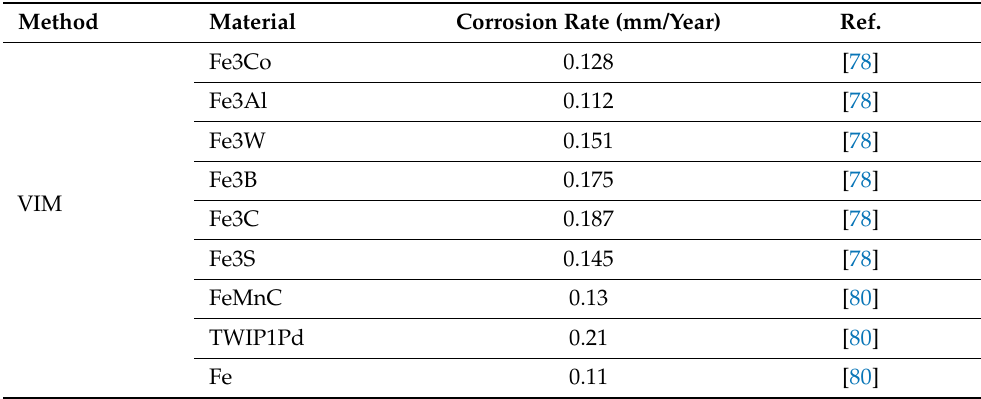
Table 4. Corrosion rates for Fe-based materials obtained by vacuum induction